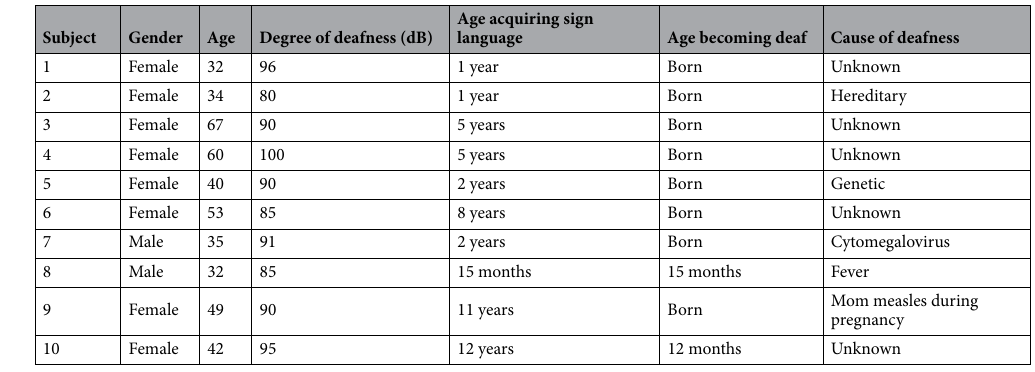
Table 1. The characteristics of deaf